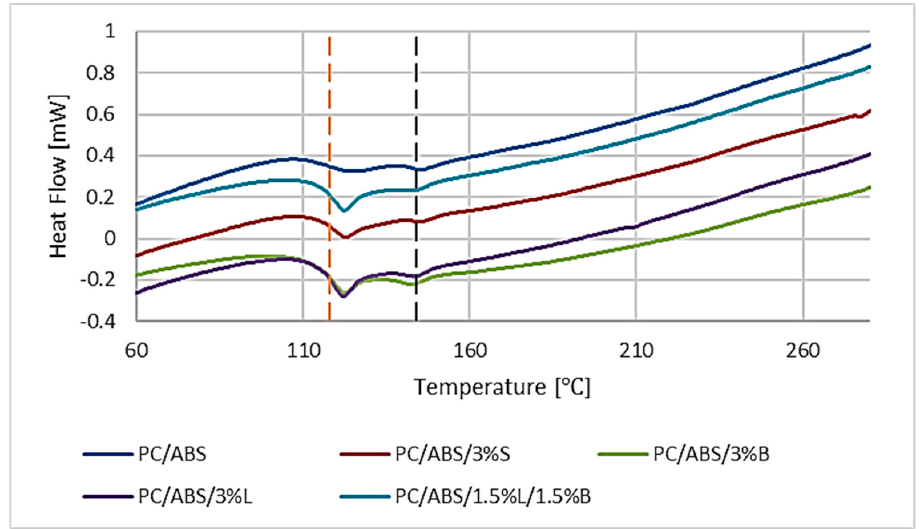
Figure 12. Results of the differential scanning calorimetry (DSC) analysis of PC/ABS and PC/ABS composites.